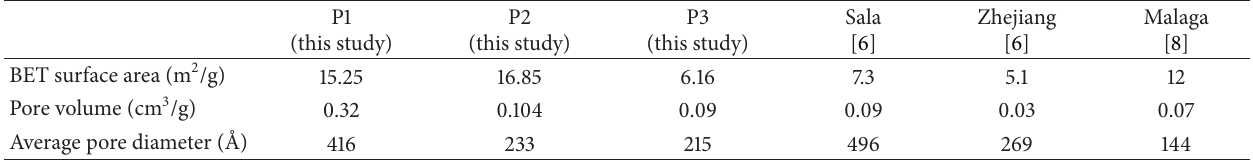
Table 2: Pore characteristics of the calcined